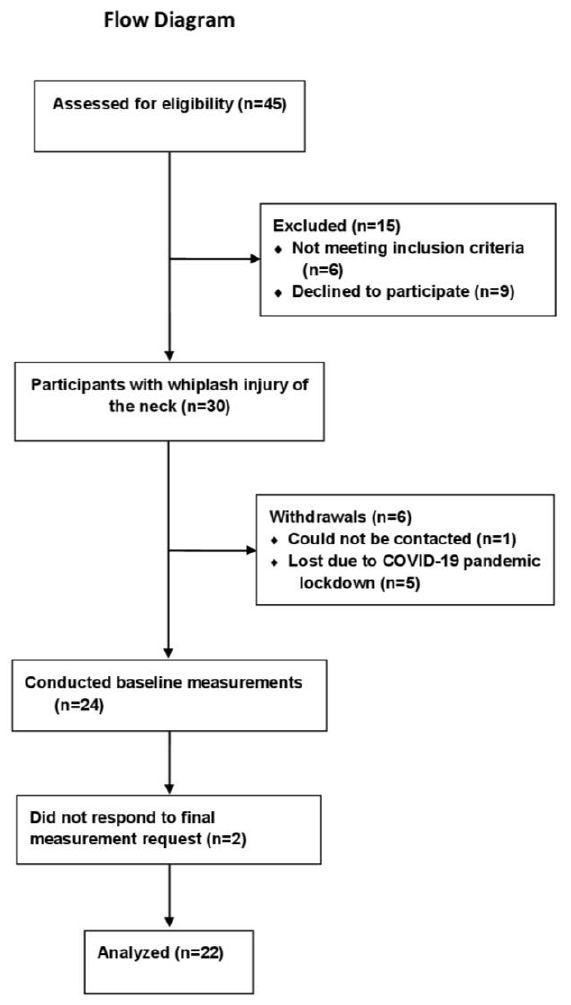
Figure 1. Flow of participants through the study.